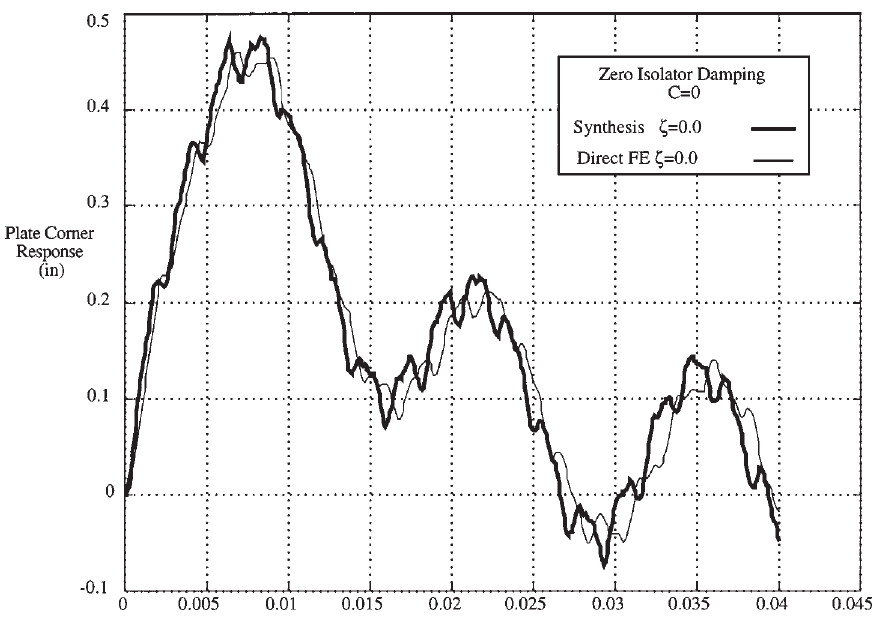
Fig. 10. Comparison of synthesis with Direct FE no damping: Plate corner (at isolator) vertical response vs